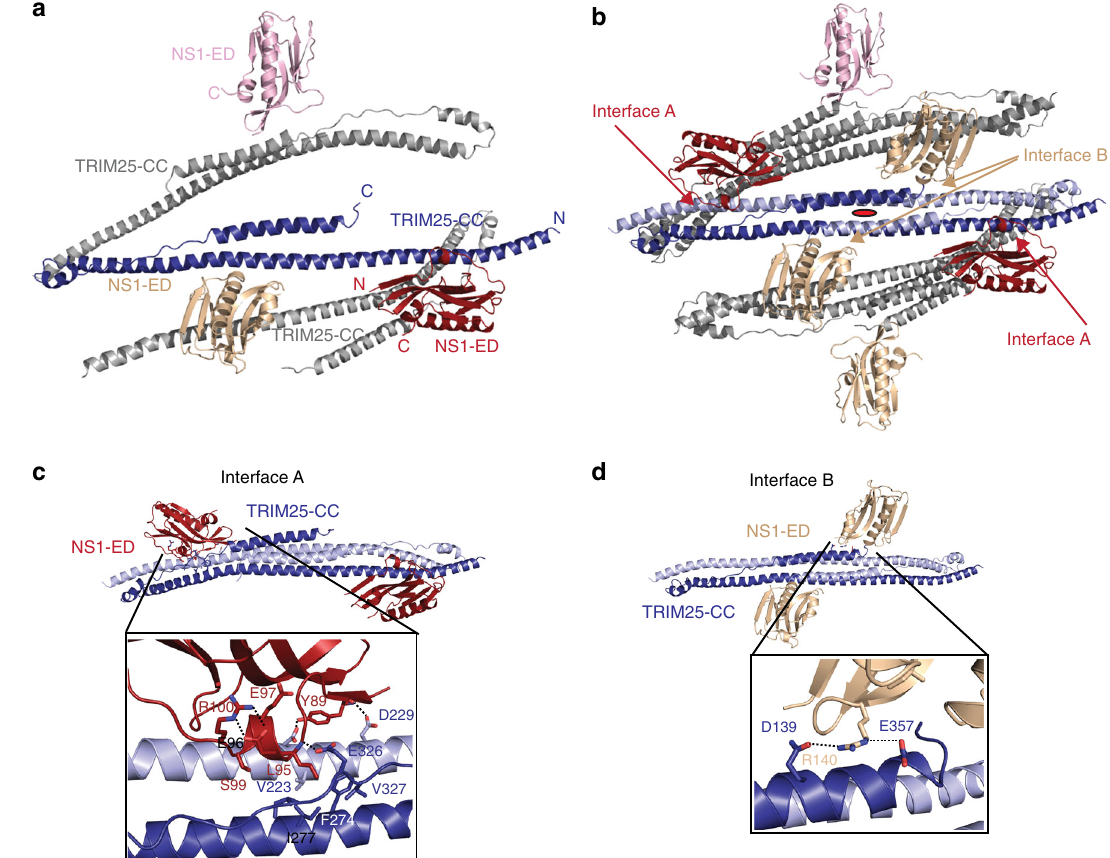
Fig. 2 Crystal structure of NS1-ED in complex with TRIM25-CC. a The asymmetric unit of the TRIM25-CC/NS1-ED complex containing three copies of each TRIM25-CC (blue and grey) and NS1-ED (in red, wheat and pink) monomers. b Symmetry analysis shows that NS1-ED binds to a dimeric TRIM25-CC via two distinct interfaces. The structure is shown in ribbon representation. The position of a twofold symmetry axis is shown in red. c Interface A is formed by the NS1-ED α -helix containing amino acids E95 and E96, which have previously been suggested to be important for complex formation. The insert shows a close-up view of the interface with TRIM25-CC in light and dark blue and NS1-ED in red. Interactions described in the text are highlighted by dashed lines. d Details of interface B, with TRIM25-CC in light and dark blue and NS1-ED in